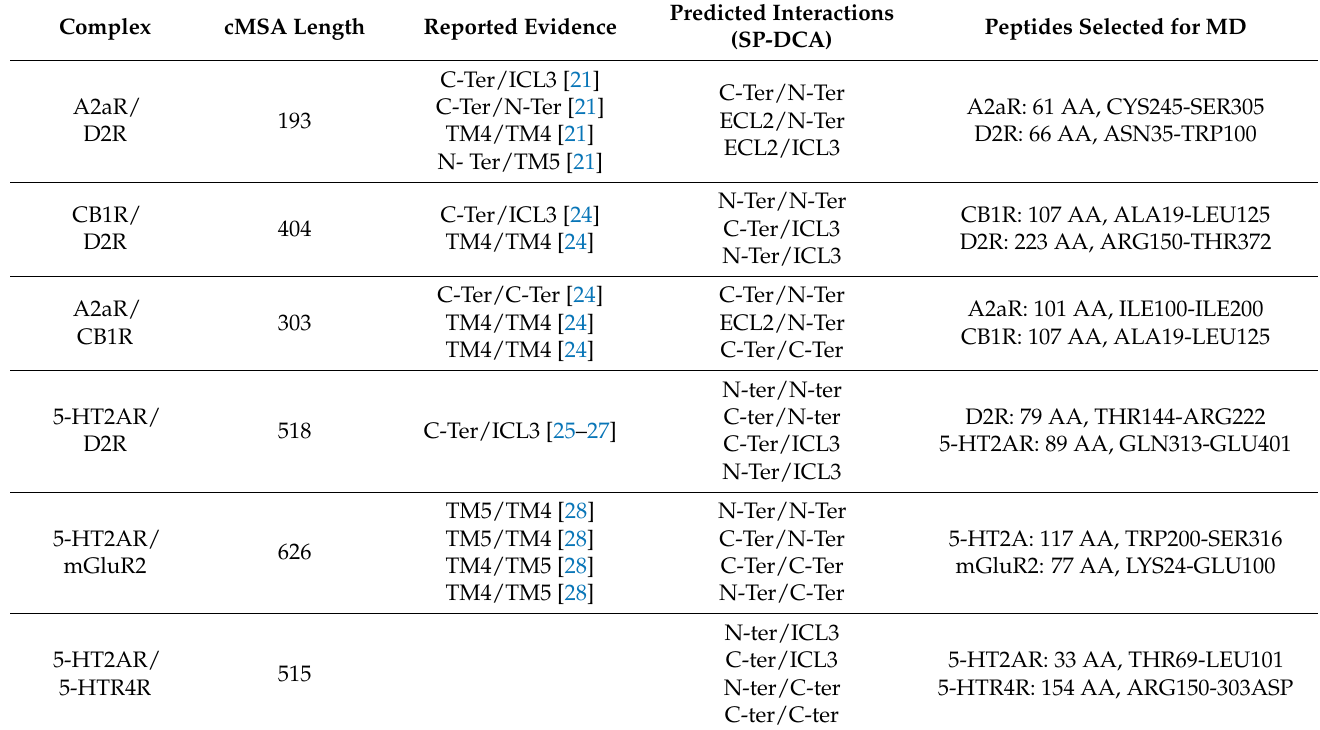
Table 1. Summary of the SP-DCA predicted and previous evidence of interactions between selected GPCRs complexes and peptides selected for molecular dynamic